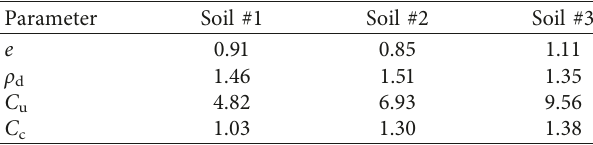
Table 2: Initial porosity and parameters for soils.